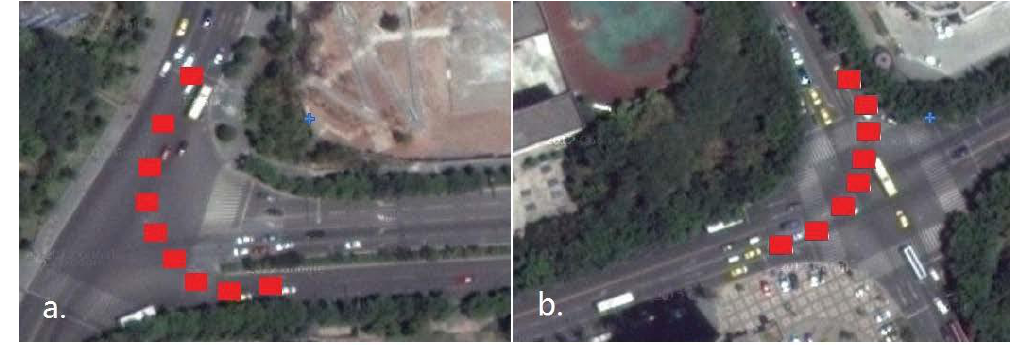
Figure 12. ( a ) T-junction and locations of 9 GPS epochs; ( b ) Crossroad and locations of 8 GPS epochs.